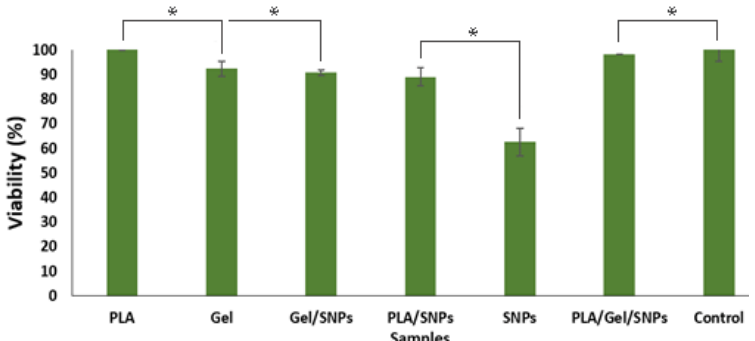
Figure 6. Viability (%) of L929 mouse fibroblast cells by Indirect MTT assay of different mats over 24 h of culture. Control: Cells and culture media without any textiles. The experiments were repeated in triplicate. Asterisks indicate statistically significant differences using Duncan’s test (* p < 0.05).